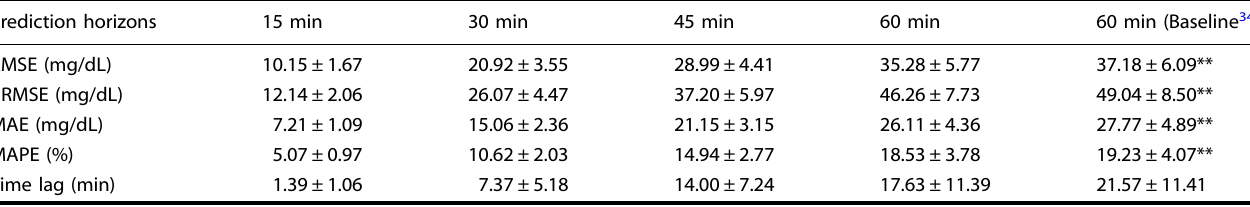
Root mean square error (RMSE), glucose-speci fi c RMSE (gRMSE), mean absolute error (MAE), mean absolute percent error (MAPE), and the time lag are employed as metrics. The best performance of the baseline methods (CRNN 34 ) is presented. The signi fi cance is indicated as ** p